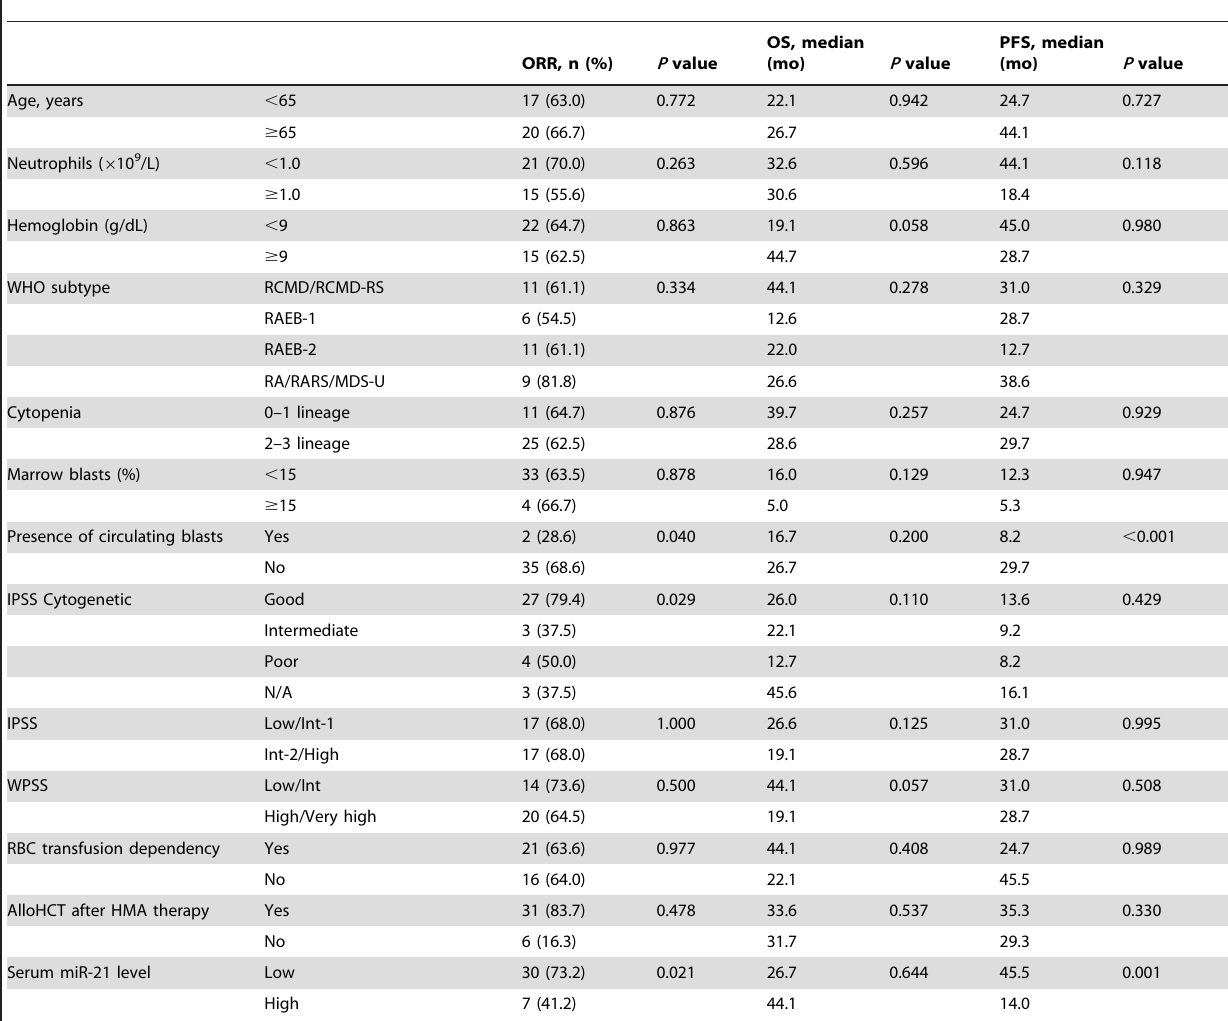
Table 3. Univariate analysis for overall response rate, overall survival, and progression-free